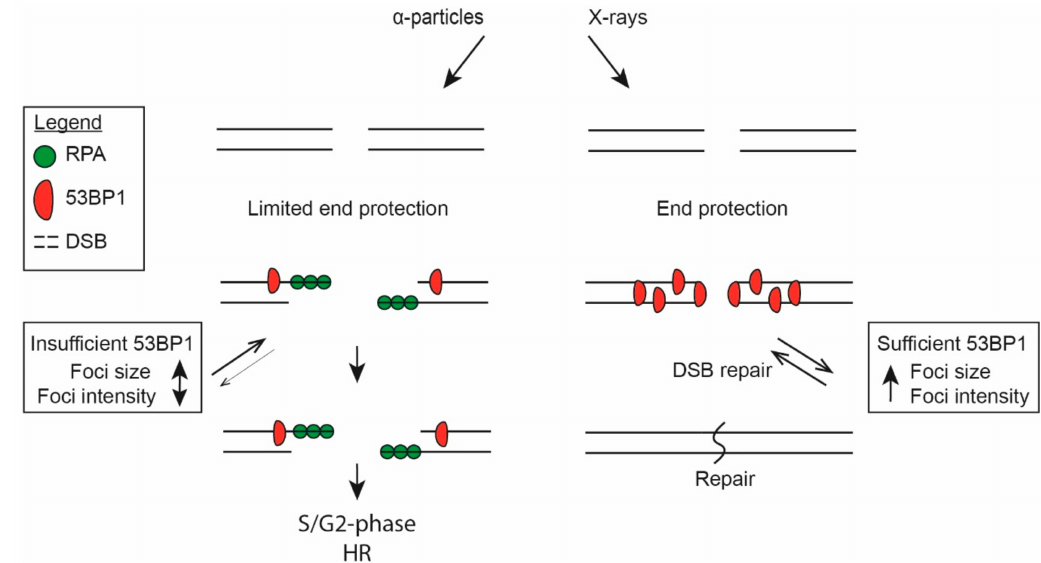
Figure 6. Working model of the role of radiation type in double-strand break (DSB) repair pathway choice. Both X-ray irradiation and α -particle irradiation induce DSBs. The DNA ends induced by X-ray irradiation are protected by 53BP1 and are repaired by the nonhomologous end-joining (NHEJ) machinery. Repair of DSBs reintroduces 53BP1 back into the general pool and causes the remaining foci to recruit more 53BP1, leading to an increase in focus intensity. Repair via the slow component of NHEJ involves chromatin decondensation, leading to focus growth. On the other hand, after α -particle irradiation, the 53BP1 pool is insu ffi cient, thereby limiting end protection and leading to resection. Resection in the S / G2 phase would activate homologous recombination (HR)-directed